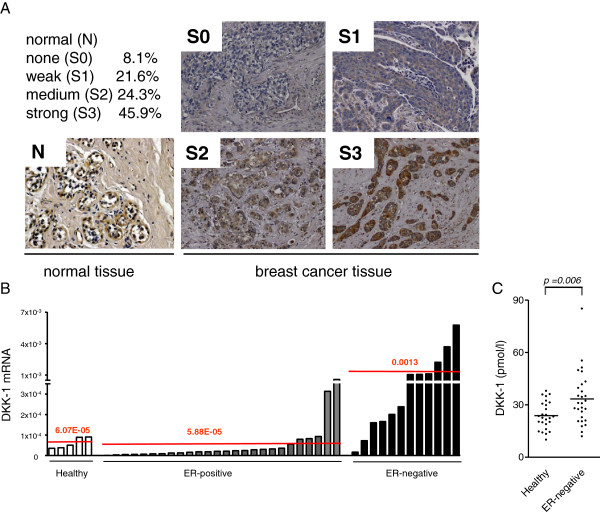
Dickkopf-1 expression in breast cancer samples and serum. (A) Dickkopf-1 (DKK-1) expression was assessed in a breast cancer tissue microarray consisting of 74 breast cancer samples and 10 normal tissues. The TMA was stained with an antibody directed against human DKK-1 and staining was graded from none (0) to strong (3). (B) A cDNA breast cancer array was used to quantify DKK-1 expression in breast cancer. Expression of DKK-1 was measured and normalized to β-actin. (C) DKK-1 serum levels are elevated (P = 0.006) in patients with estrogen receptor (ER)-negative breast cancer (n = 28) or in healthy controls (n = 27). Patients’ characteristics are listed in Figure S3B in Additional file
1.